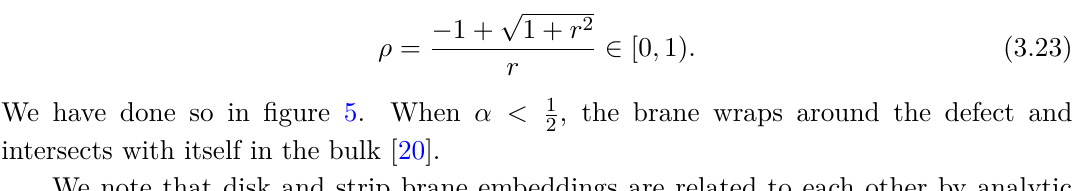
Figure 5. Cross sections of | T | = 1 / 2 strip branes for decreasing values of α . For α = 1 , the brane’s endpoints are antipodal. For α < 1 / 2 , the brane self-intersects in the bulk. It is enlightening to plot these lines on the Poincaré disk, which has the radial